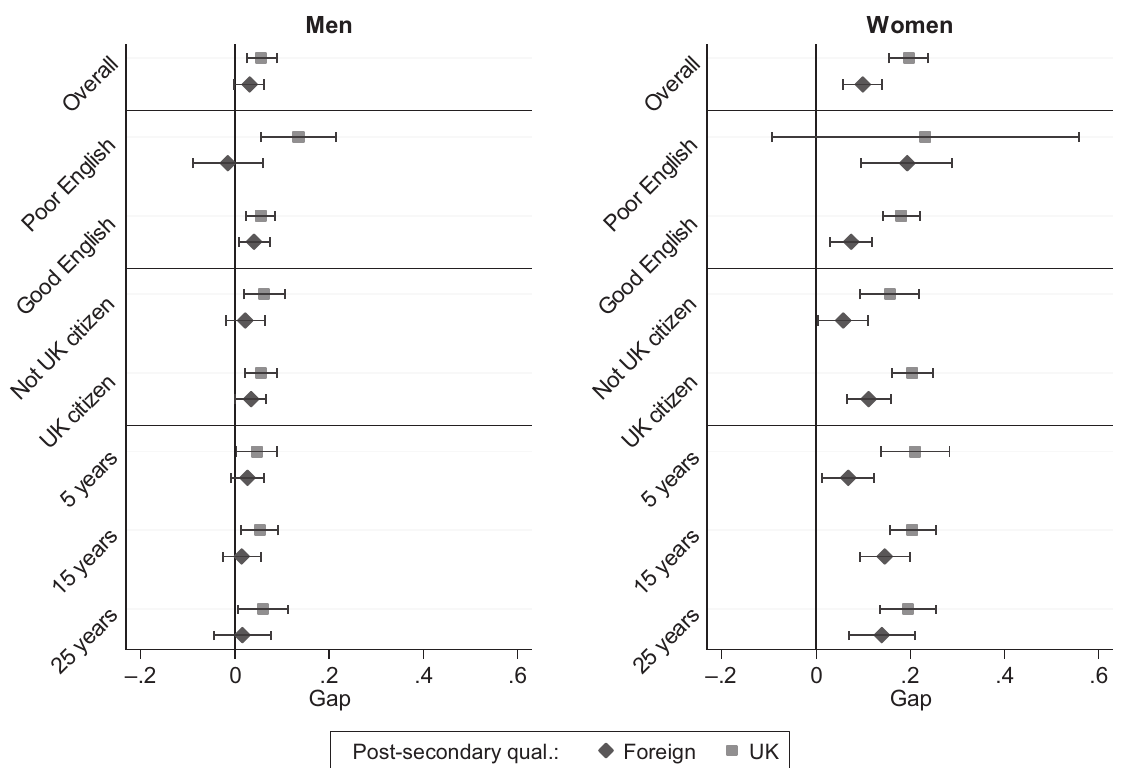
Figure 3. Estimated effect of having foreign or UK post-secondary qualifications over post-secondary qualifications on em- ployment for